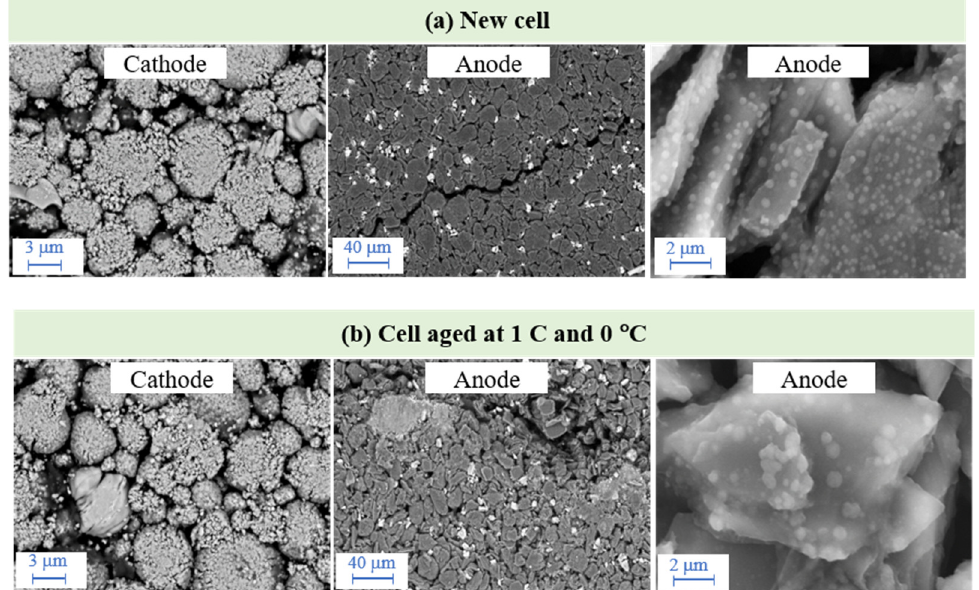
Figure A4. SEM images for electrodes from new and cold aged cells (SEM: ZEISS Ultra 55; acceleration voltage of secondary electron detector: 15 kV).